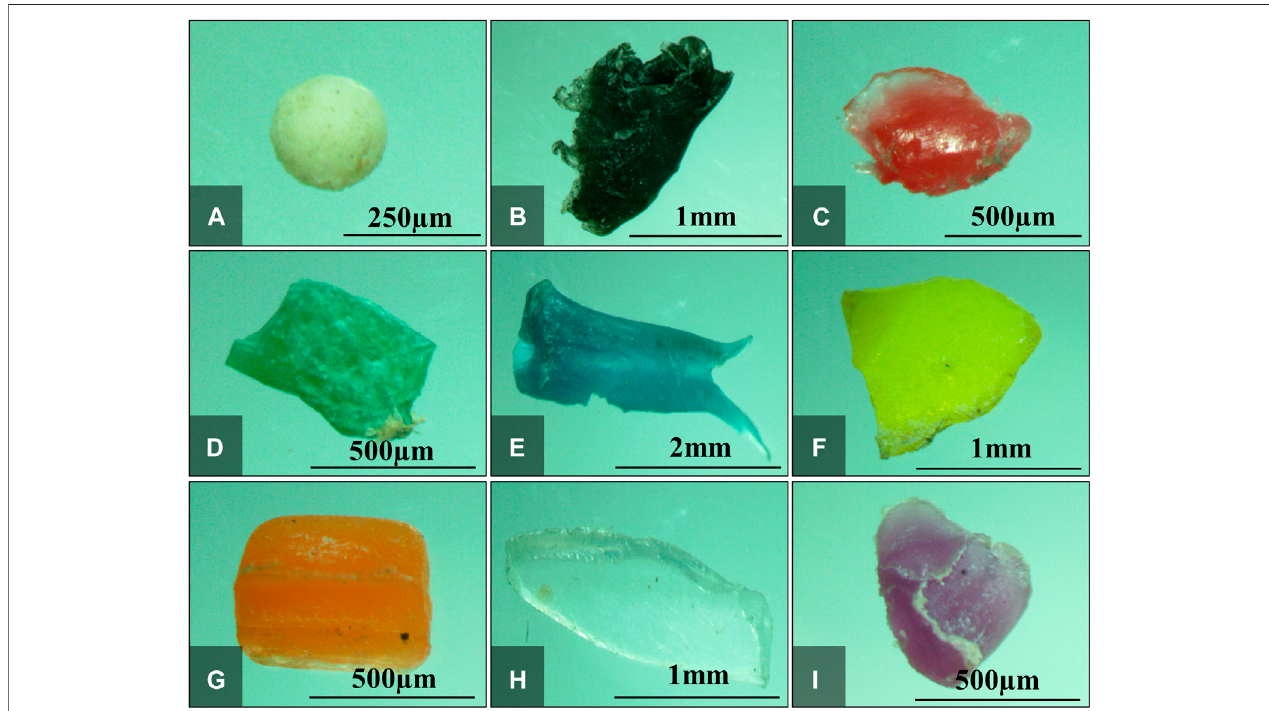
FIGURE 6 | Photographs of different colors of microplastics collected in all samples – (A) white, (B) black, (C) red, (D) green, (E) blue, (F) yellow, (G) orange, (H) transparent, and (I) violet.